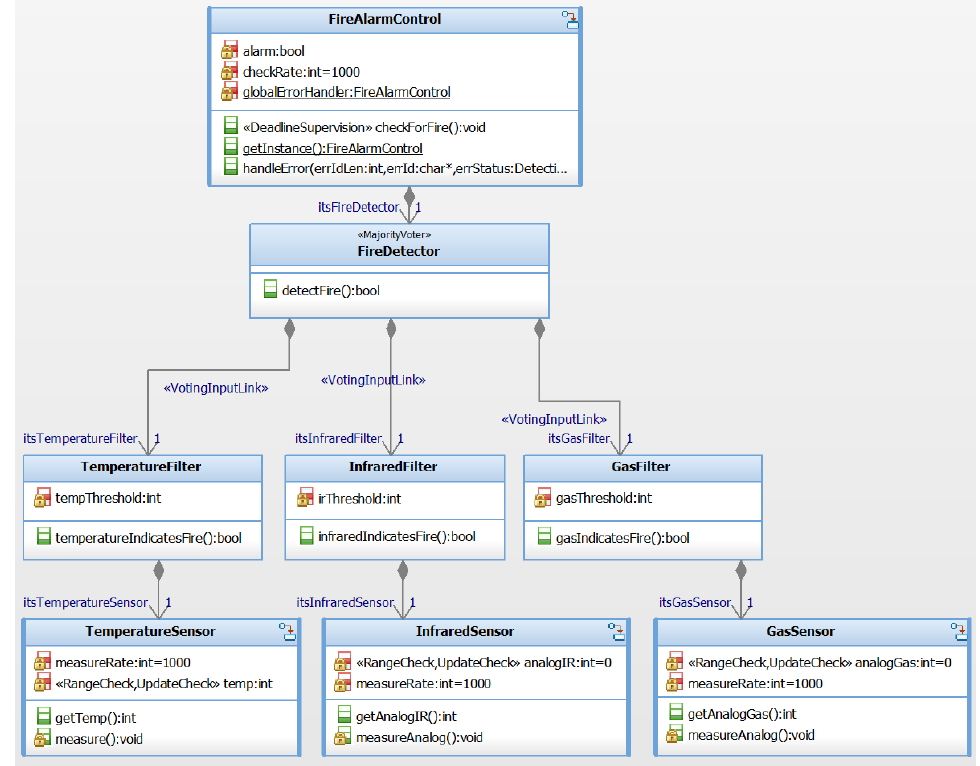
Figure 4. Model of the fire detection application with safety stereotypes applied (screenshot of a IBM Rhapsody class diagram). Classes that do not contain a safety mechanism according to the requirements presented in Section 4.2.2 have been